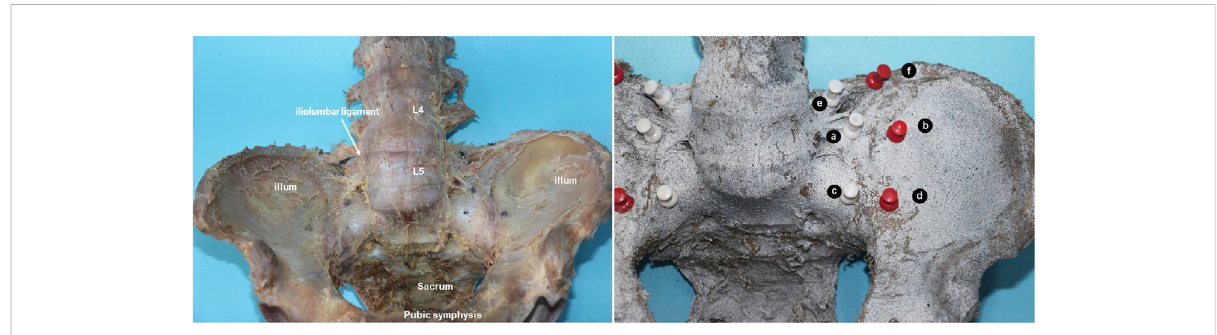
FIGURE 1 Preparedpelviccadavericspecimenandthethreepairsofmarkers. (A) Medialpointintheleftanduppersacroiliacjoint; (B) laterpointintheleft